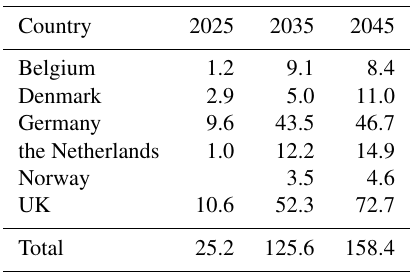
Table 4. Aggregate North Sea region results for the countries in focus in the scenario with sector coupling.